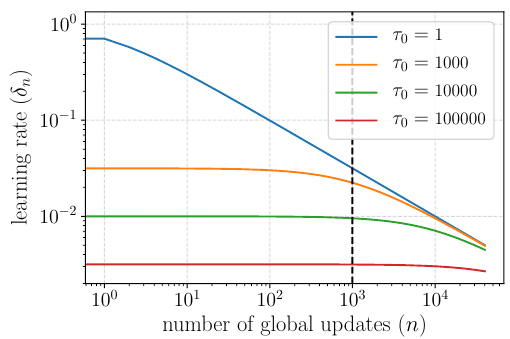
Figure 15 . The learning rate as a function of the number of global updates for di(cid:11)erent o(cid:11)sets, (cid:28) 0 = 1-10 5 . The black dashed line indicates the learning rate after 100 passes when we have 10 5 events in the sample and a chunk size of 10 4 , as in the scans in section 5 and appendix A.